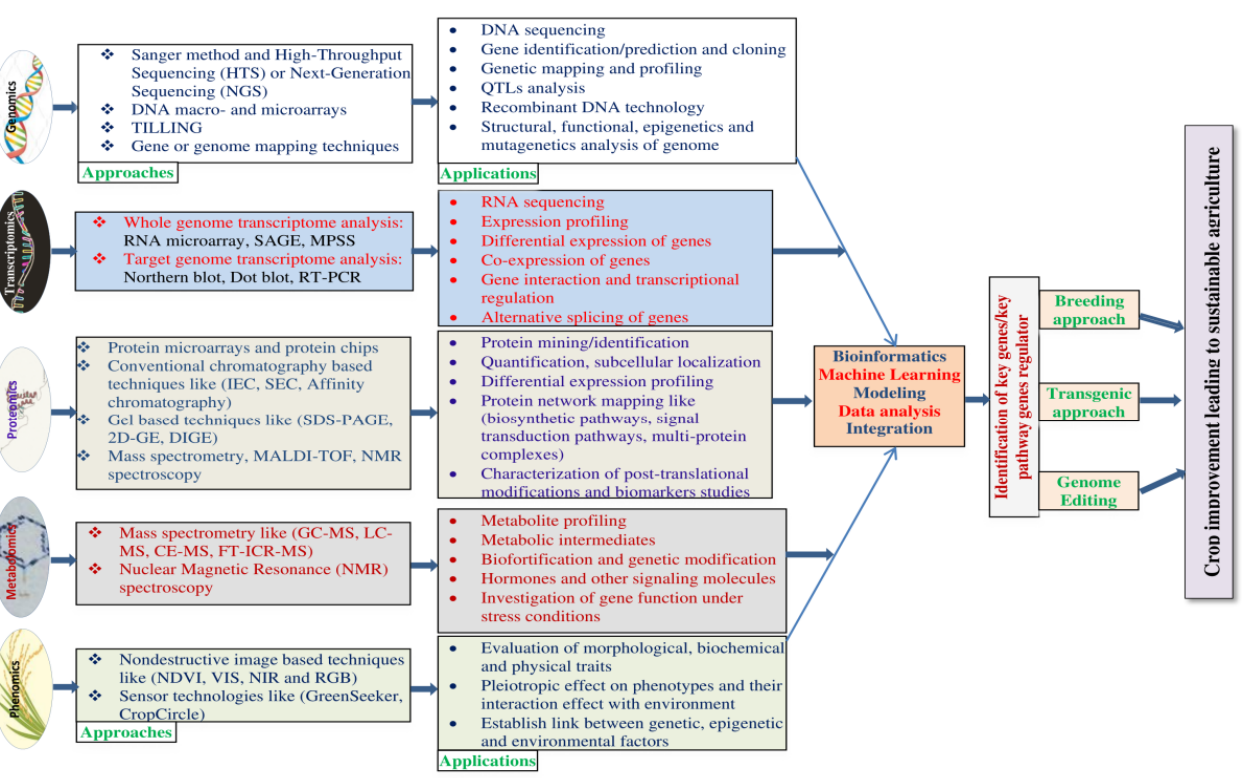
Figure 3. Schematic diagram of integrated omics for stress-tolerant rice improvement. To comprehend the complex features and to identify the key genes or regulators involved in salt tolerance, omics-based platforms should be merged. Essential genes need to be validated using functional genomic methods. Table 3. Online databases available for rice integrated omics analysis.